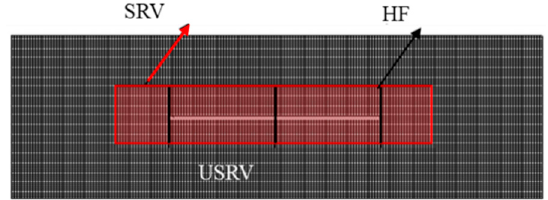
Figure 7. Schematic diagram of a MFHW numerical model ( y l = y e ).